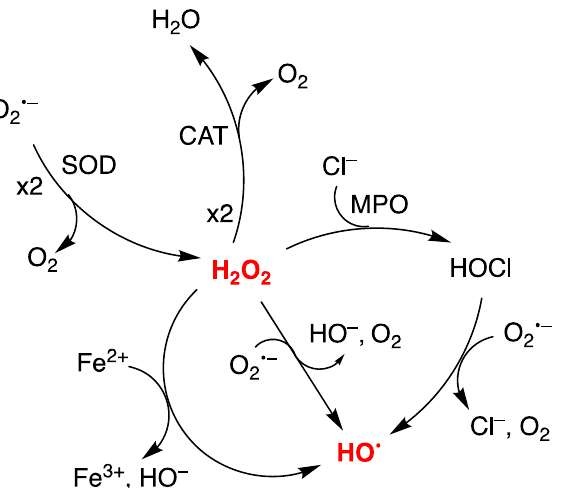
Figure 1. Relevant pathways of the reactive oxygen species (ROS) network: hydroxyl radical (HO • ) formation from superoxide radical anion (O 2 •− ) in the mitochondria. SOD: superoxide dismutase; CAT: catalase; MPO: myeloperoxidase.